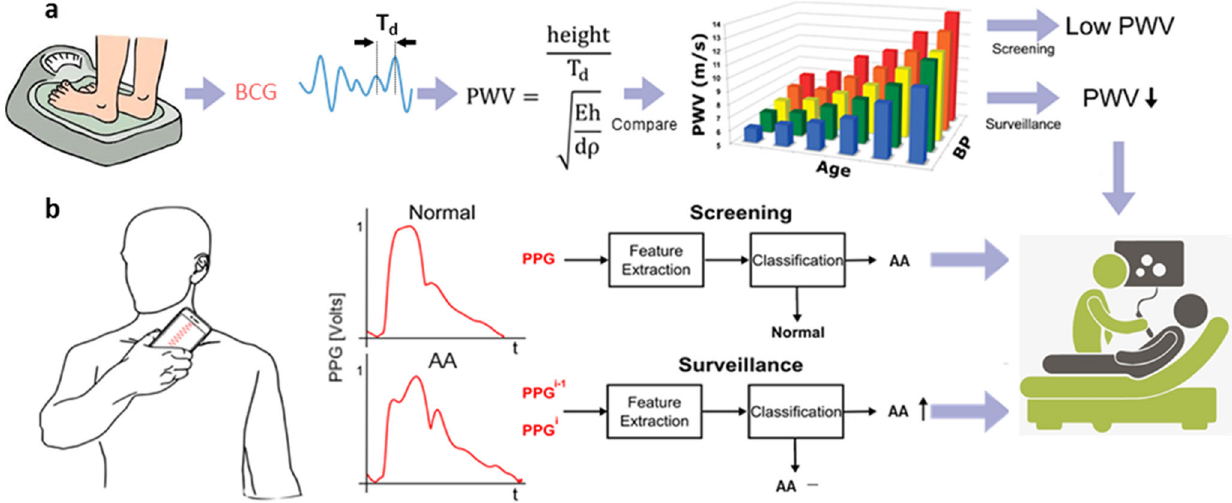
Fig. 1 Potential convenient point-of-care devices for abdominal aortic aneurysm (AAA) monitoring via arterial waveform analysis. a A sensitive weighing scale for measuring a ballistocardiography (BCG) waveform and detecting aortic pulse wave velocity (PWV) 19 . PWV decreases with increasing AAA diameter (d) per the Moens-Korteweg equation (where E is the elastic modulus of the aortic wall; h, wall thickness; and ρ , blood density) but also increases with blood pressure (BP) and age (bar graph adapted from 24 ). b A hand-held unit for measuring a photoplethysmography (PPG) waveform from the carotid artery. The waveform shape during systole is altered due to the early, negative wave re fl ection in AAA 13 . Such devices may be best used to indicate if an accurate, but less convenient, ultrasound scan should be ordered.